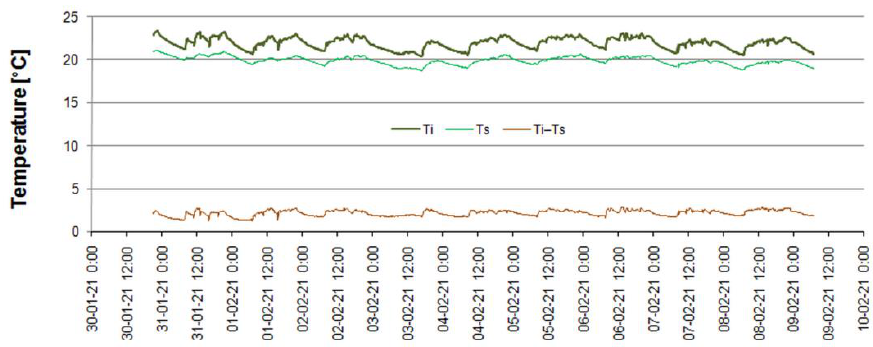
Figure 7. Wall surface temperature (T s ), internal air temperature (T i ) and their difference. The calculated CHTC varied throughout the whole period (Figure 8) from 0.069 W/m 2 K (at 6:30 on 5 February) to 3.027 W/m 2 K (at 14:10 on 2 February), with an average of 1.153 W/m 2 K. The EN ISO 6946 standard gives the value h c = 2.5 W/m 2 K for the inter- nal surface of the vertical wall. The recommended internal surface resistance in such a case is R si = 0.13 m 2 K/W. Taking the measured average h r = 5.445 W/m 2 K we obtain